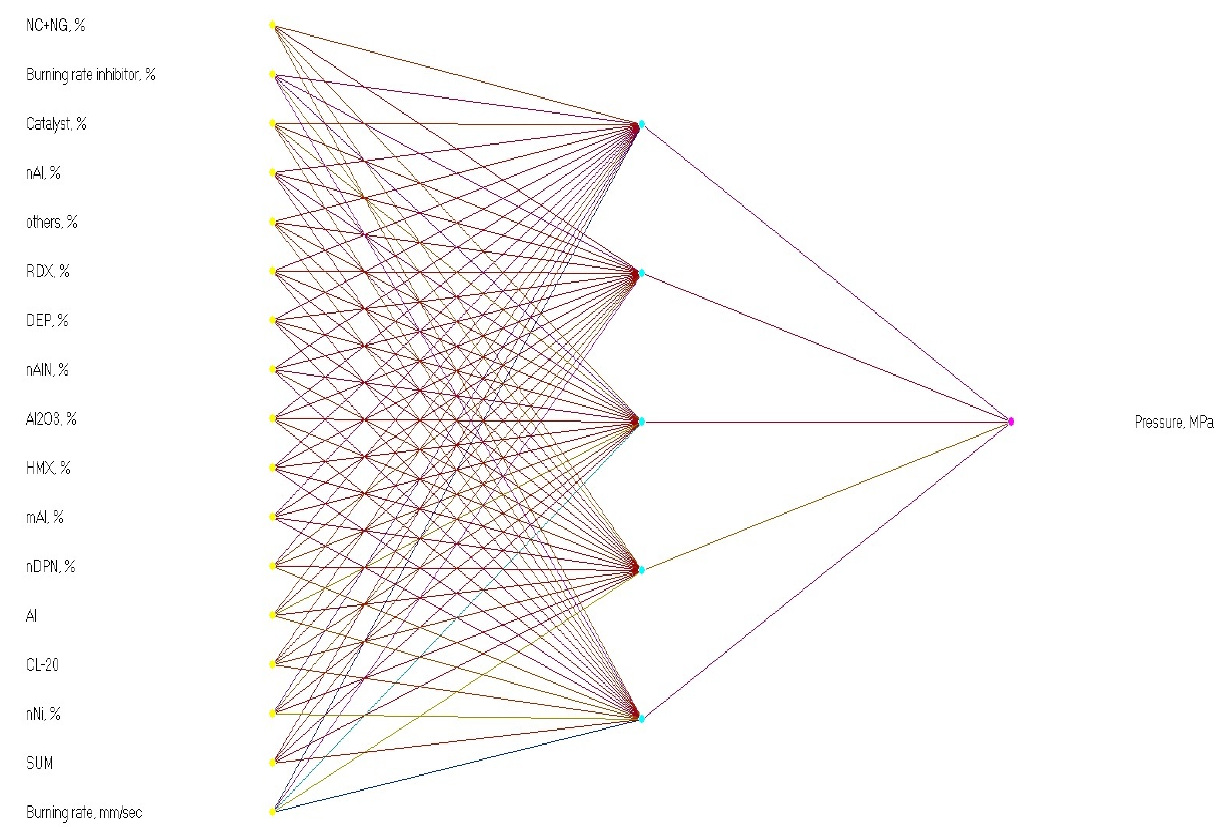
Figure 6. ANN structure for the simplest form of inverse task.